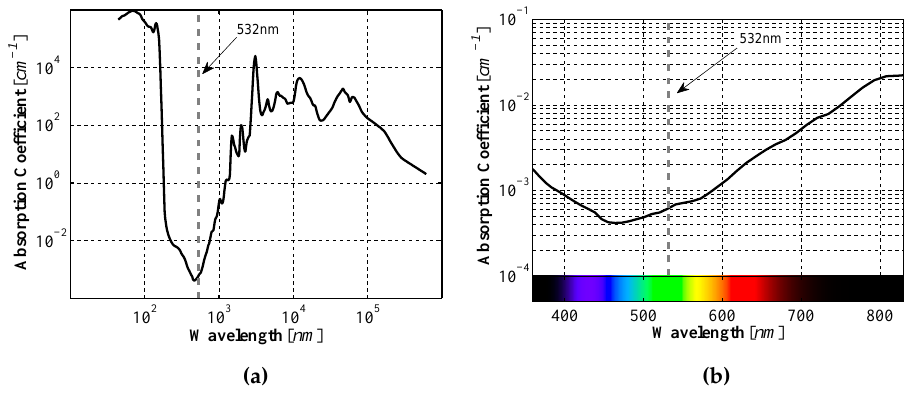
Figure 2. Absorption coefficient of light in water as a function of wavelength over ( a ) the total spectrum; and ( b ) the visible spectrum. (obtained using data from